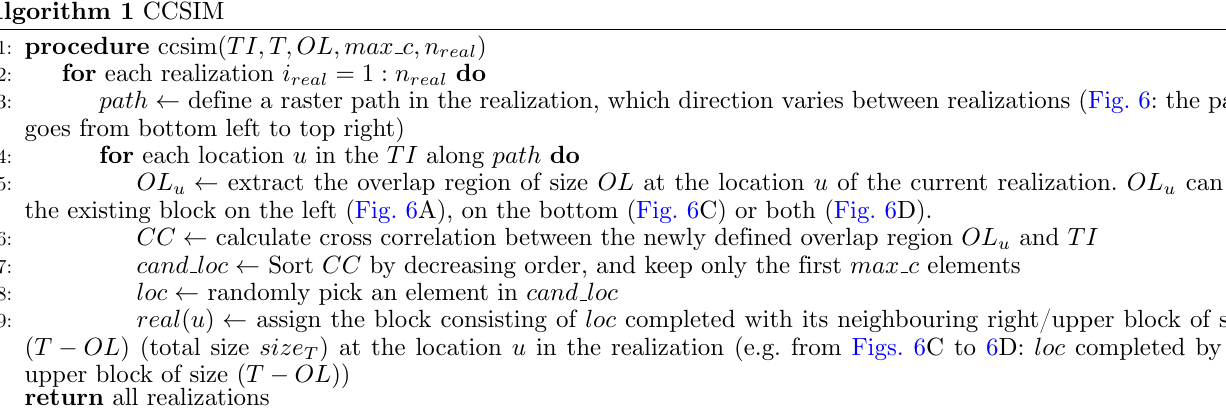
Algorithm 1 CCSIM